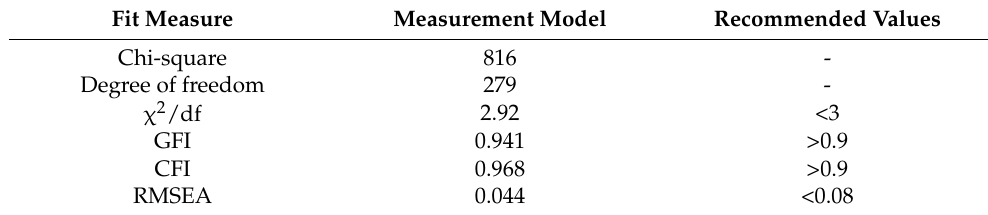
Table 5. Fit measures for measurement model.